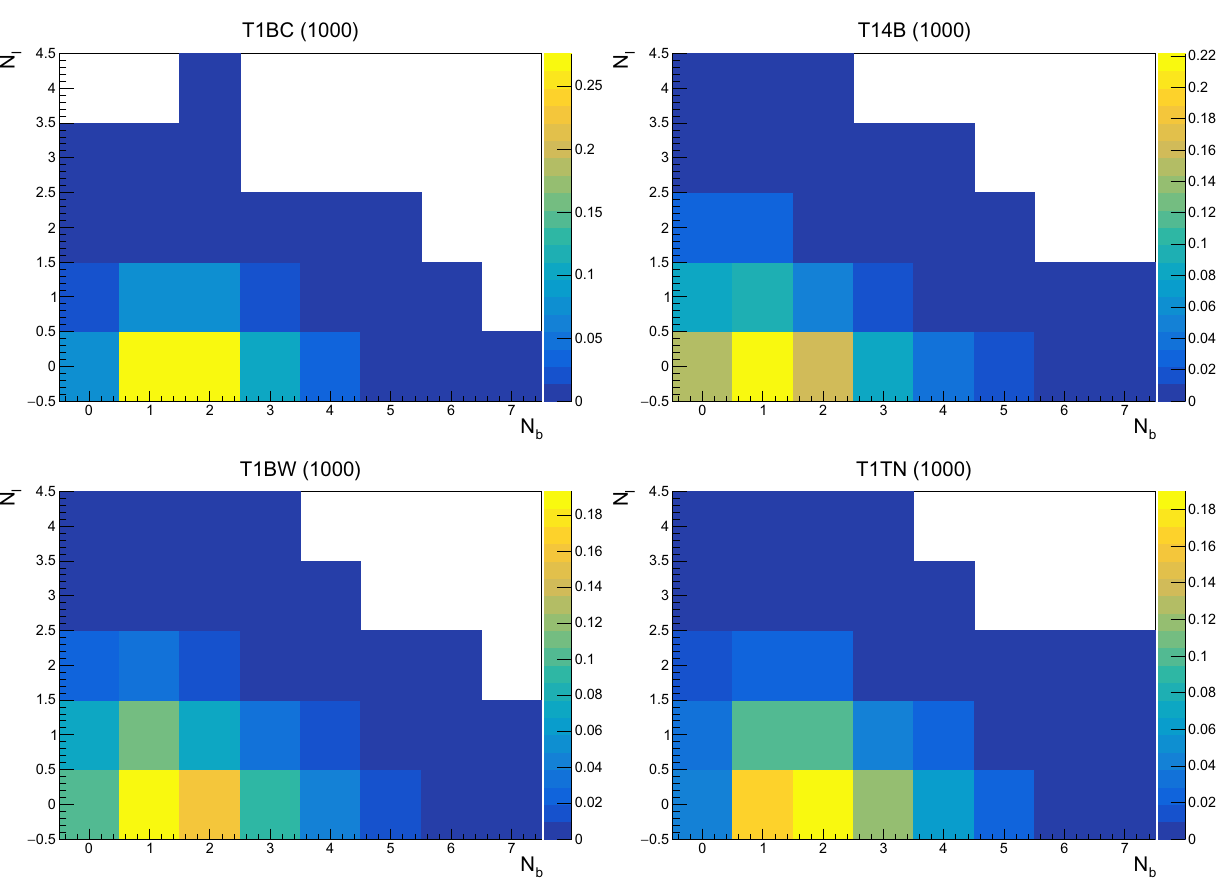
Fig. 2 The number of b-jets N b and the number of leptons N (cid:2) distributions for our benchmark points with m ˜ t jets provides as a good probe to study the light stop sector, ∼ m + m . However, for some of especially when m ˜ t ˜ χ 0 t 1 1 our benchmark points, e.g. T14B, the small mass